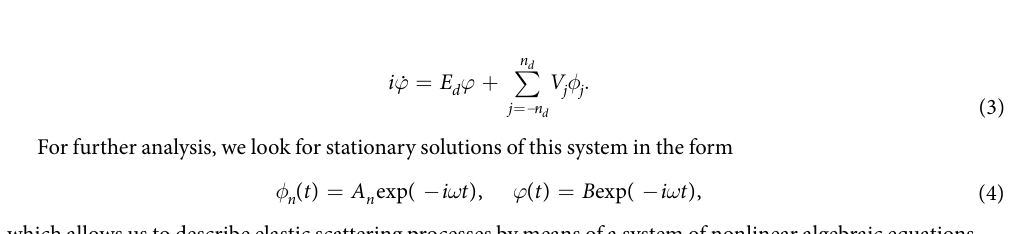
Figure 2. Localized defects in armchair graphene nanoribbon with the width D = 1.229 nm: ( a ) concave edge defect ED + 2 (two additional carbon atoms); ( b ) convex edge defect ED − 2 (two carbon atoms missing); ( c ) double vacancy V 2 (585); ( d ) Stone-Wales defect SW(5577); (e) single vacancy V 1 (59); ( f ) inverse Stone-Wales defect I 2 (7557). ( g ) Nanoribbon of the width D = 3.192 nm with an transverse array of the inverse Stone-Walles defects. Gray color marks a change of the lattice structure introduced by the presence of a